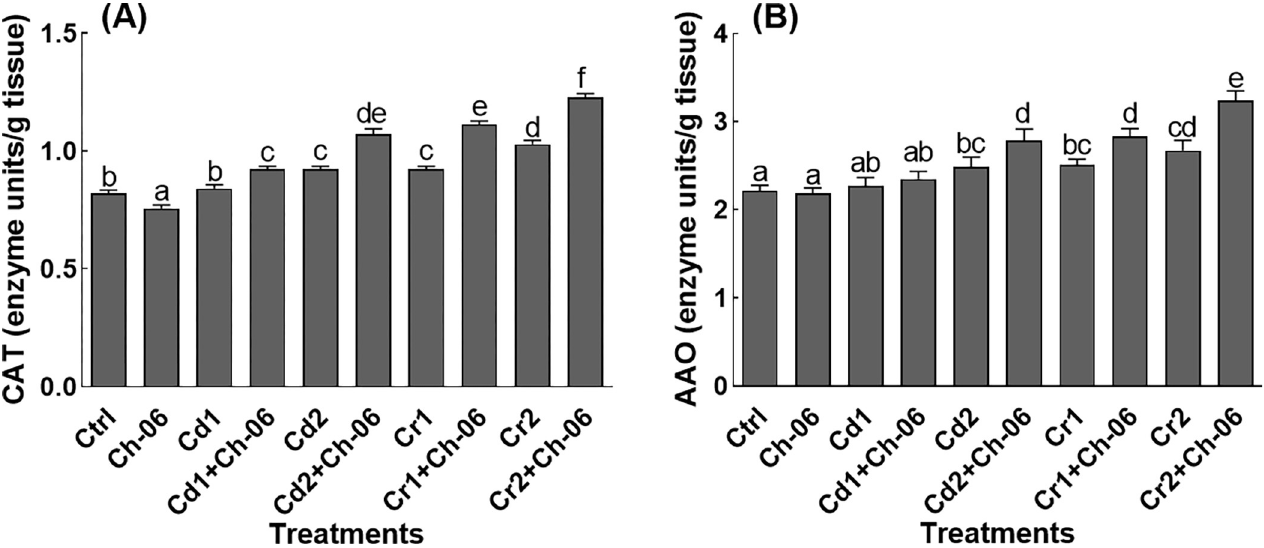
Fig 8. Impact of Ch-06 ( A . violaceofuscus ) on CAT and AAO levels of okra under elevated Cd and Cr stress. Co: Control, Cd = cadmium, Cr = chromium, Cd1 and Cr1 = 100 μ g/g, Cd2 and Cr2 = 500 μ g/g. (A): Catalase, (B): Ascorbic acid oxidase. The data reflect the mean of triplicated data followed by ± SE. The data with different superscript letter are significantly different at P =